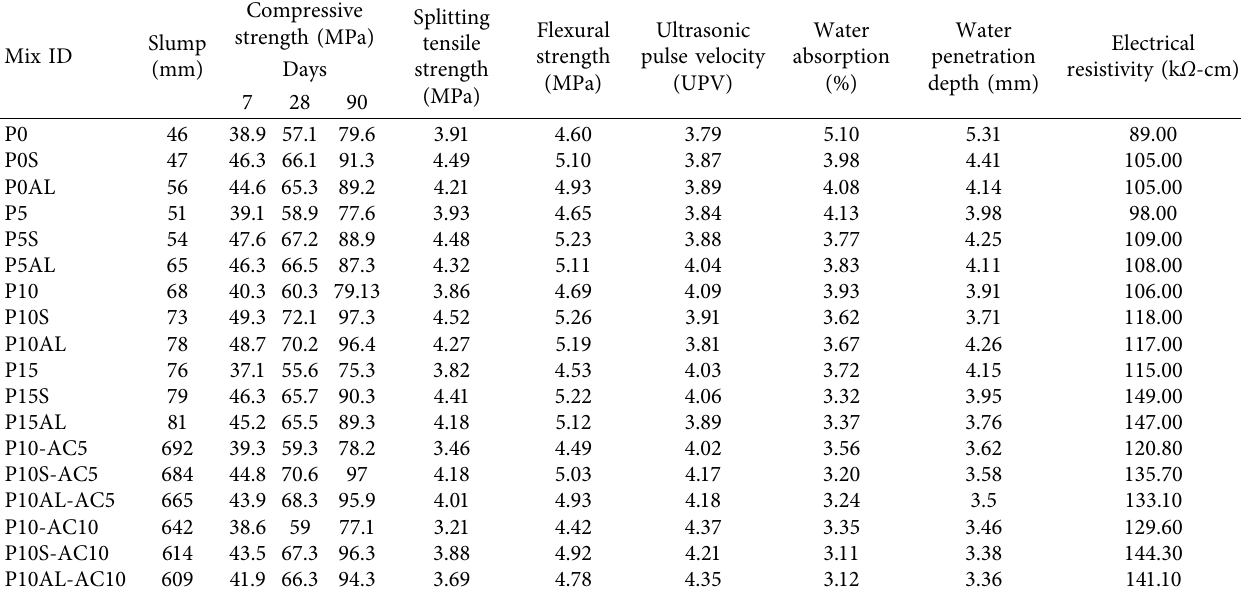
Table 1: Te properties of specimens containing waste paper sludge ash, silica nanoparticle, aluminium oxide nanoparticles, and acrylic resin [25].